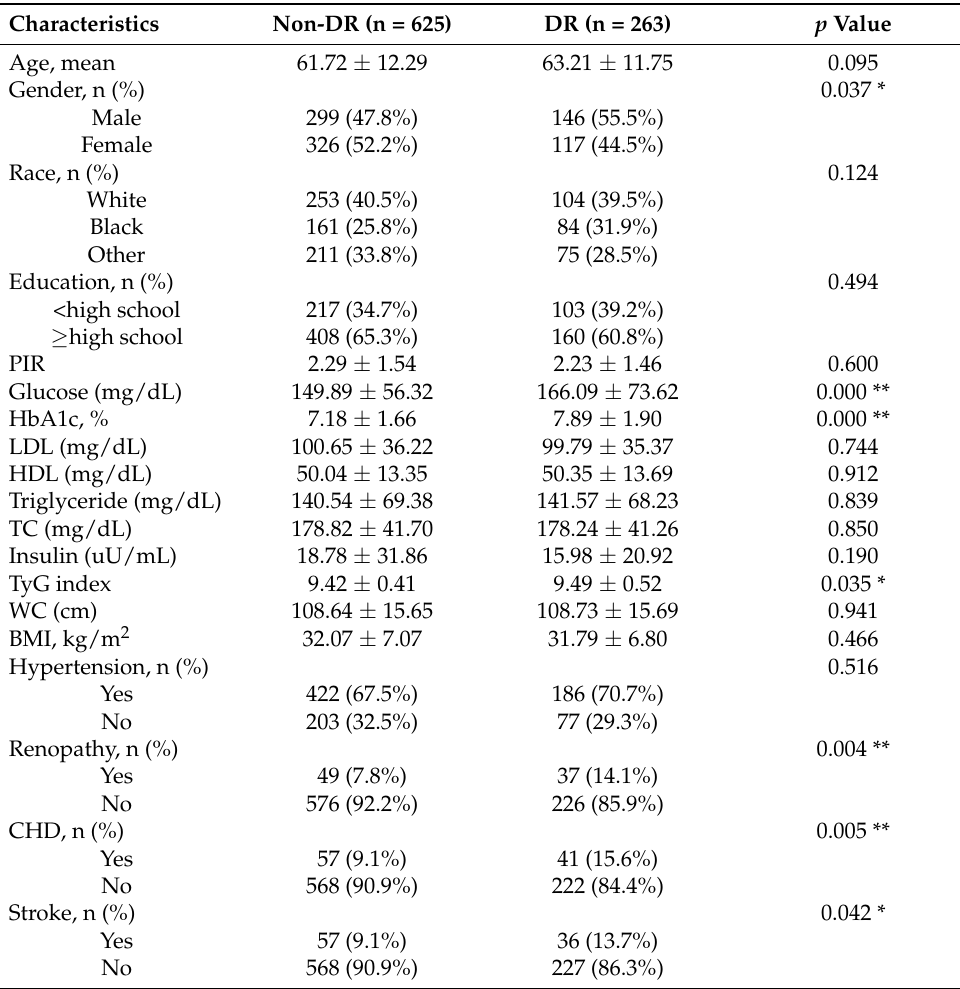
Table 1. Baseline characteristics of diabetes in the NHANES